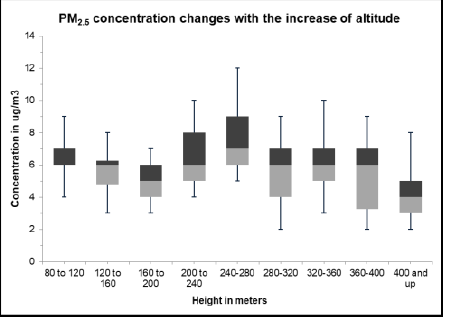
Figure 13. Boxplot of PM 2.5 concentration changes with the increase of altitude on March 22nd.